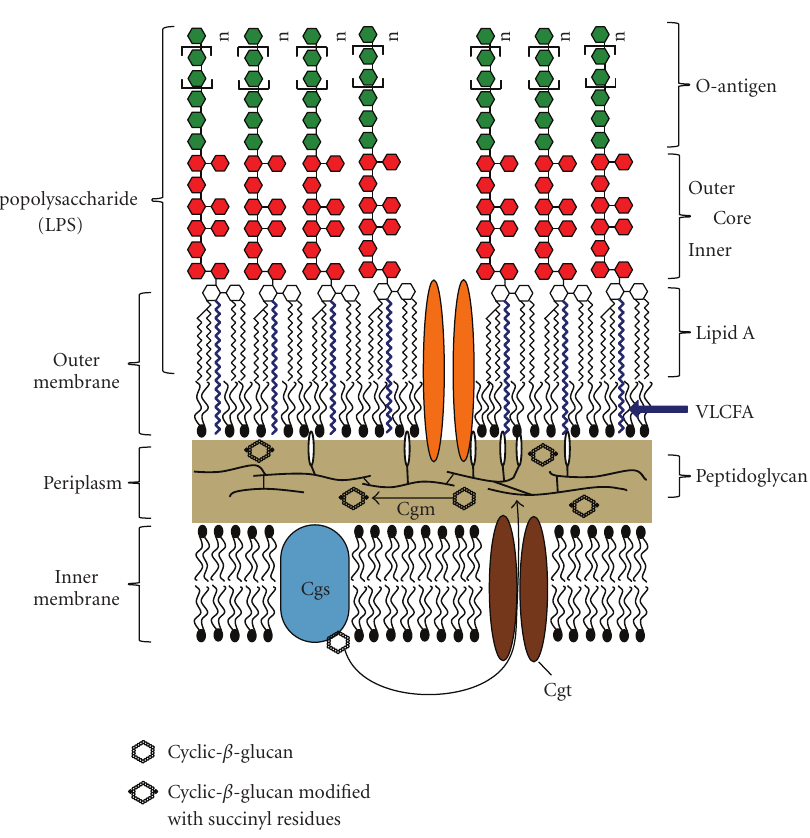
Figure 2: Diagrammatic representation of the Brucella cell envelope. The cell envelope is comprised of an inner membrane, consisting of a bilayer of phospholipids, and an outer membrane with an inner leaflet of phospholipids and an outer leaflet of lipopolysaccharide (LPS). LPS consists of three components. The O-antigen faces the extracellular space and it is the component that is recognized by the adaptive immune response. The O-antigen is connected to a sugar core molecule composed of di ff erent sugars which have not yet been fully identified. Lipid A forms the hydrophobic anchor of LPS within the membrane and has a backbone of diaminoglucose, which is acylated with saturated and hydroxylated fatty acids. Brucella lipid A contains an unusual very-long-chain fatty acid (VLCFA). Cyclic β -1,2-glucans are synthesized by the inner membrane protein Cgs and then transported to the periplasm by the predicted ABC-transporter Cgt where they are modified with on average two succinyl residues by a predicted membrane protein